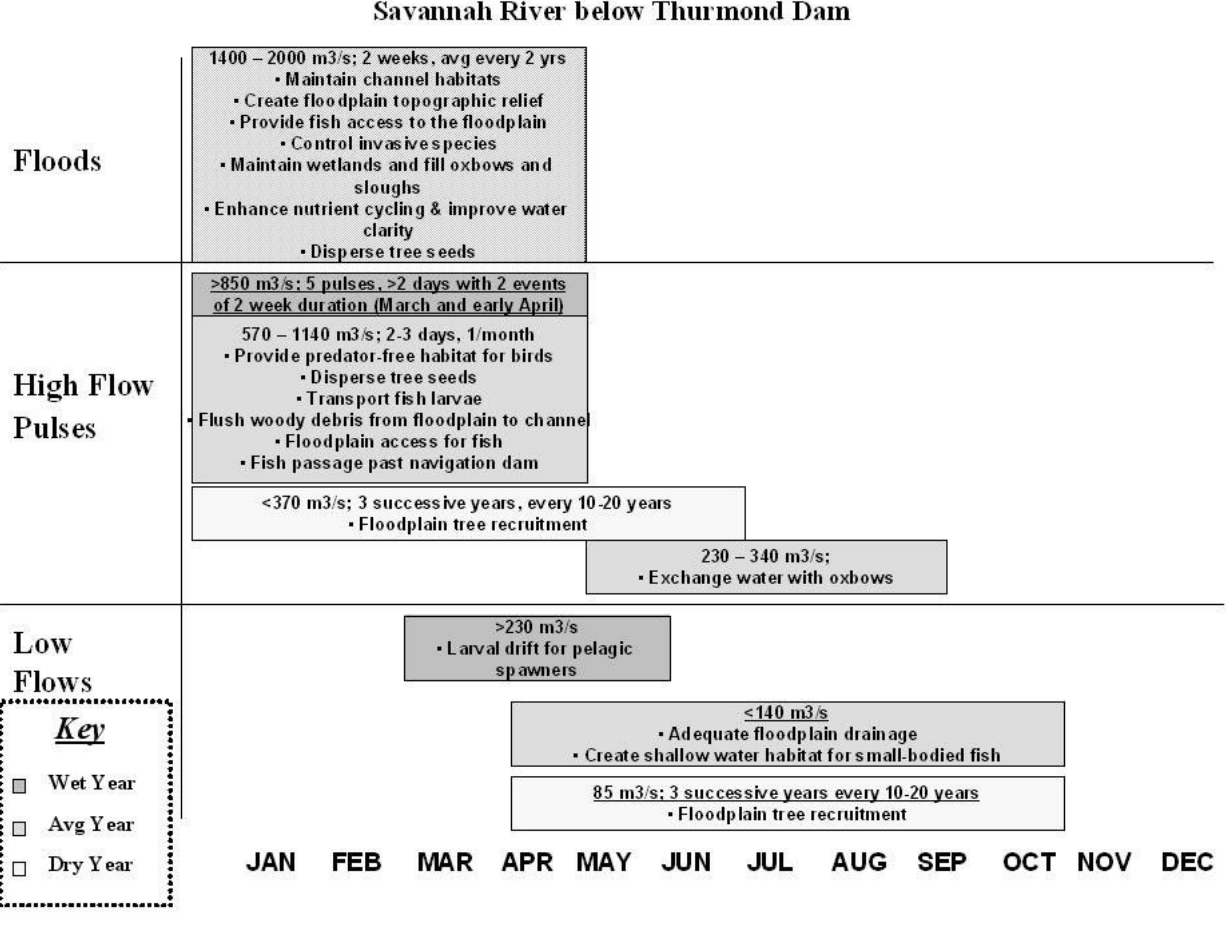
Fig. 6. The ecological goals for a dam re-operation project on the Savannah River in the southeastern United States are summarized in this diagram. Specific ecological outcomes are noted in each box, which is linked to particular levels and durations of water release from the dam during specified times of the year, or during various water year types, e.g., wet, average, dry. Many of the ecological goals represented in this diagram were championed by economic or social interests, such as commercial fishing (adapted fom Richter et al.